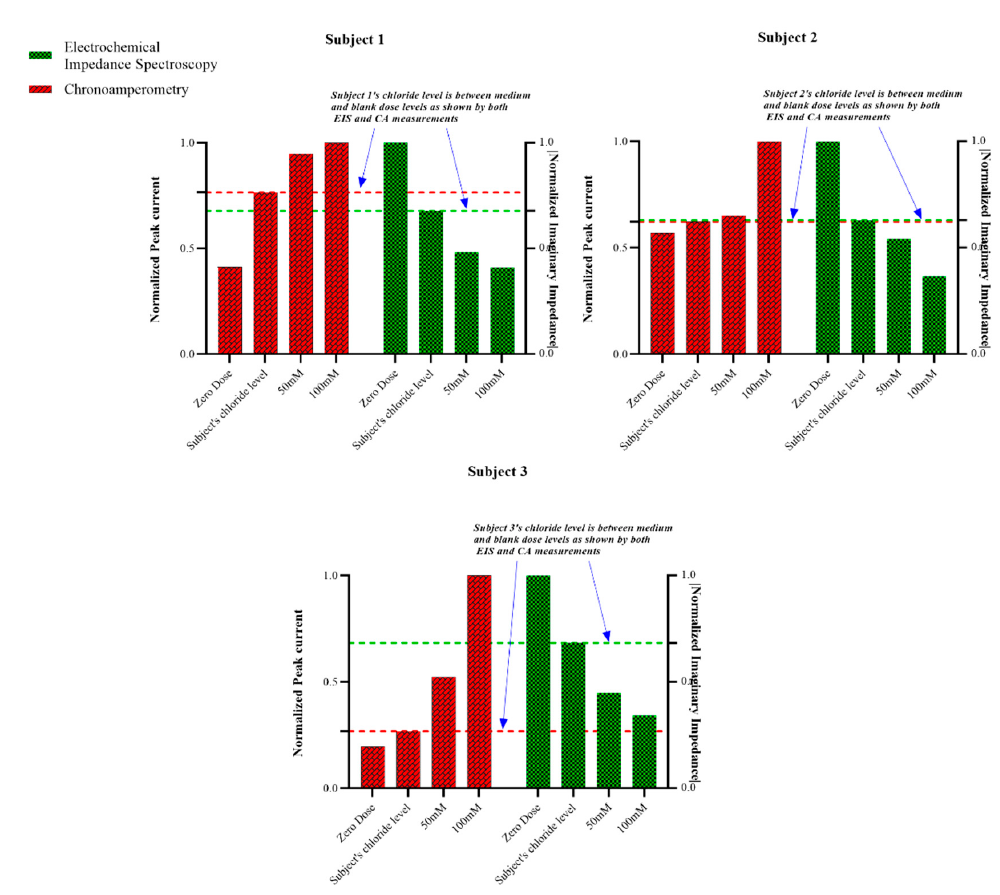
Figure 7. On-body tests for three human subjects (n = 3) done by EIS (100 Hz) and Chronomaperometry indicate that subjects 1, 2 and 3 were healthy.